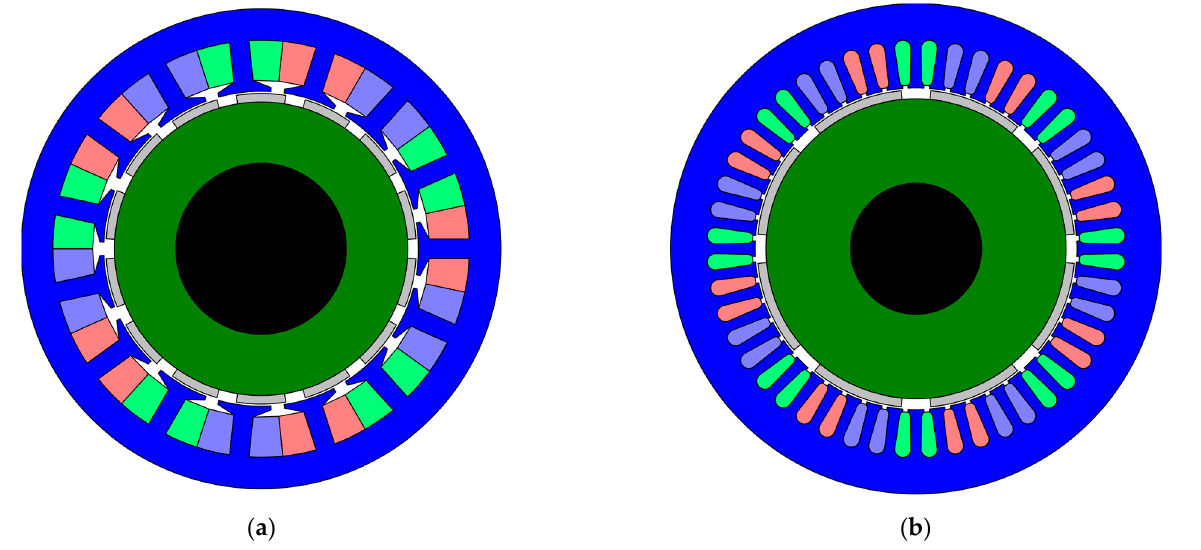
Figure 6. SPM motor with ( a ) concentrated windings and ( b ) distributed windings.